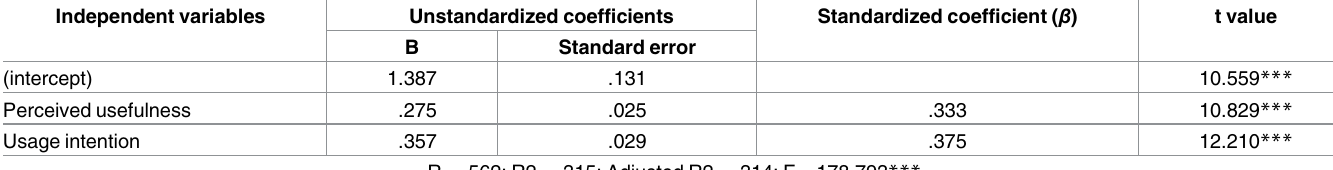
Table 7. Path analysis coefficient summaryof “perceived usefulness” and “usage intention” to “information sharing behavior”.